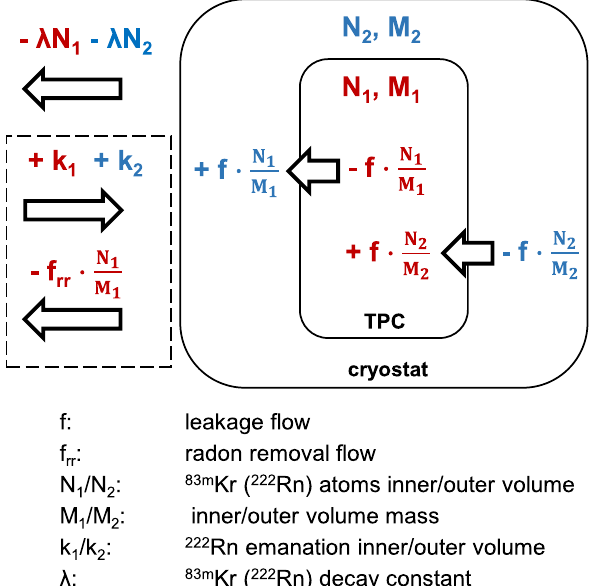
Fig. 4 Sketchofthevarioustermstodescribetheevolutionofanimpu- rity concentration (here: 83m Kr or 222 Rn) in an hermetic TPC. The red (blue) terms represent factors influencing the evolution of the number of impurity atoms N 1 ( N 2 ) in the inner (outer volume). The terms in the dashed box describe the constant emanation of impurities into the system and their removal in a purification system and only apply for the discussion of the 222 Rn concentration in